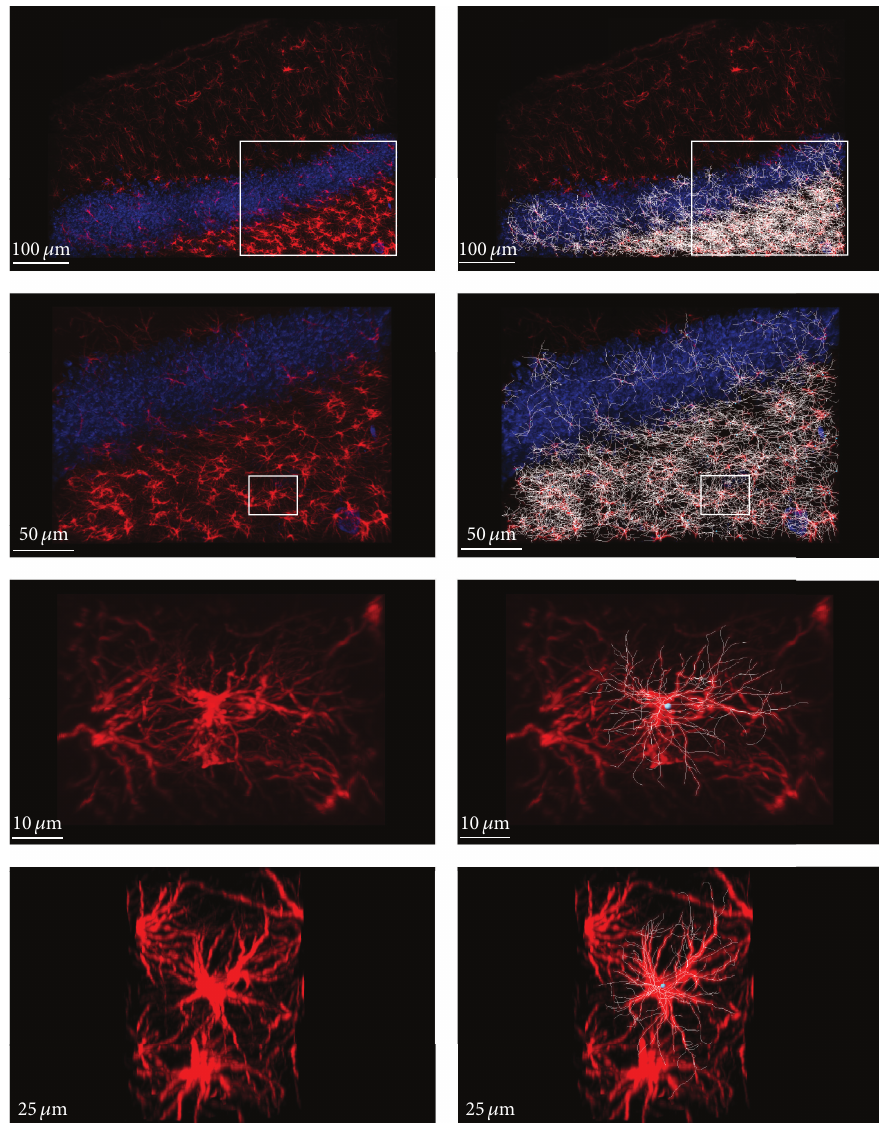
Figure 2: Astrocytes within the granule cell layer and hilus of the dentate gyrus were semiautomatically traced, segmented, and analyzed using Imaris